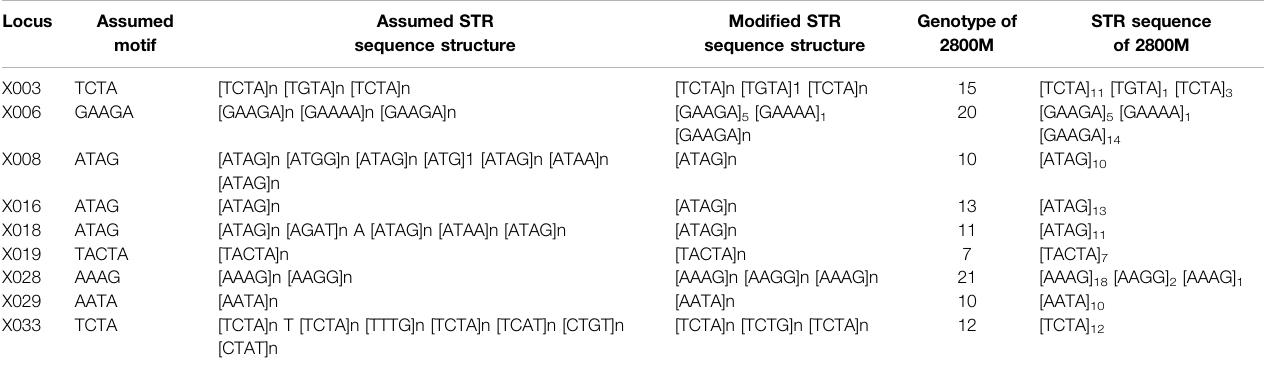
TABLE 2 | Sequence structure of the repeats of the nine novel X-STRs.